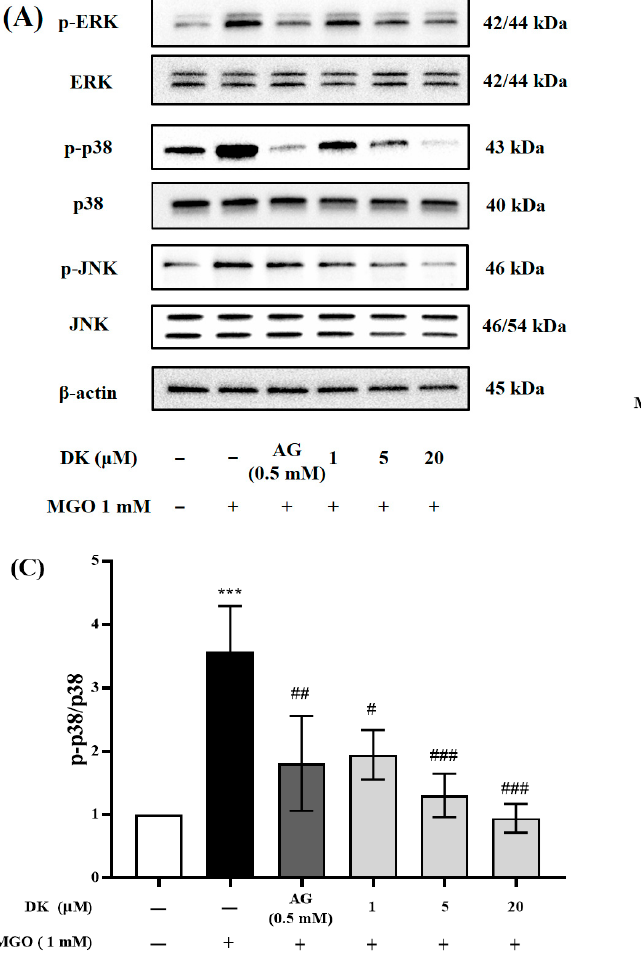
Figure 7. Effects of DK on MAPK phosphorylation in mouse glomerular mesangial cells. Cells were pretreated with DK (1, 5, and 20 µ M) or AG (0.5 mM) for 1 h. Then, 1 mM MGO was added and incubated for 23 h. ( A ) The protein expression levels of p-ERK/ERK, p-p38/p38, and p-JNK/JNK were measured by Western blot; ( B – D ) bar values showing the relative protein expression band intensity level of p-ERK/ERK, p-p38/p38, and p-JNK/JNK. All data are presented as mean ± standard deviation ( n = 3) (*** p < 0.001 vs. nontreated cells and # p < 0.05, ## p < 0.01, ### p < 0.001 vs. MGO-treated cells).